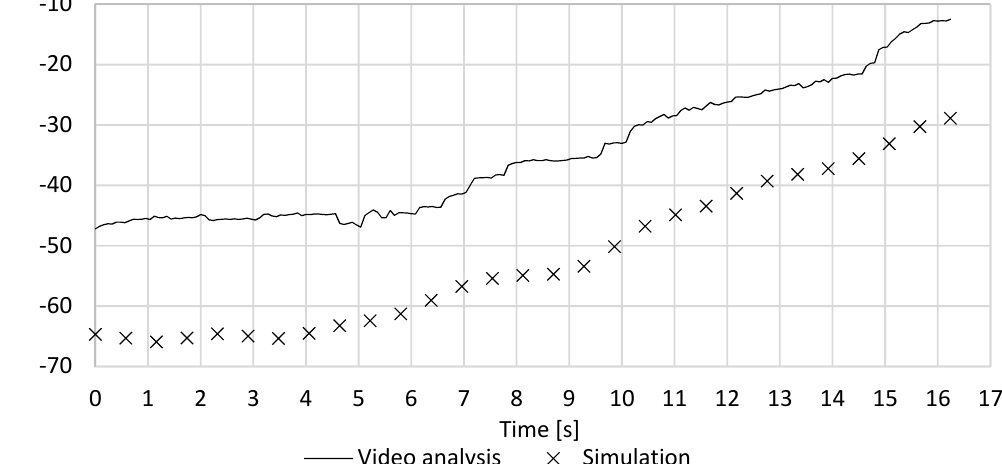
Figure 21. Comparison of δ for the test and simulation versus time. Table 3. Angular errors of the finger joints and driving links.